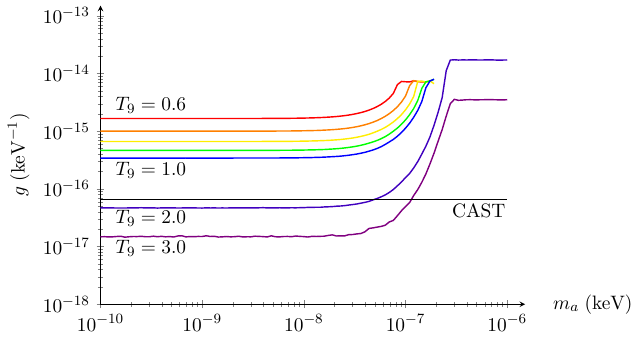
Figure 5 . Exclusion contours in the ( m a ; g ) plane for di(cid:11)erent magnetar core temperatures. For a given magnetar core temperature, all the ALP parameter space above the corresponding curve is excluded. The computations are done for SGR 1806-20 assuming r 0 = 10 km and B 0 = 20 The magnetar core temperatures span the range from T 9 = 0 : 6 to T 9 = 3 : 0 where T 9 = T= (10 9 K). From top to bottom, the curves correspond to T 9 = 0 : 6, 0 : 7, 0 : 8, 0 : 9, 1 : 0, 2 : 0 and 3 : 0 respectively (i.e. the red, orange, yellow, green, blue, indigo and violet curve). For comparison, the exclusion contour from CAST is shown in